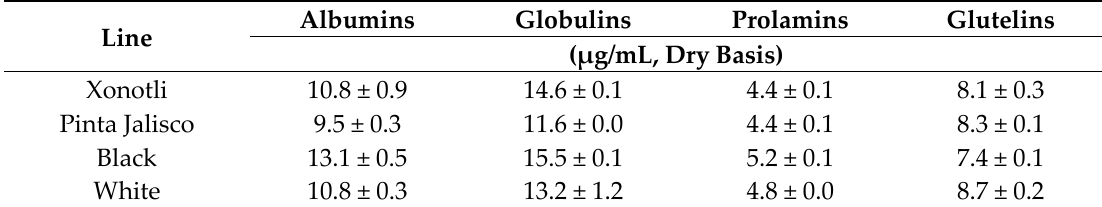
Table 3. Concentration of proteic fractions from chia seeds.